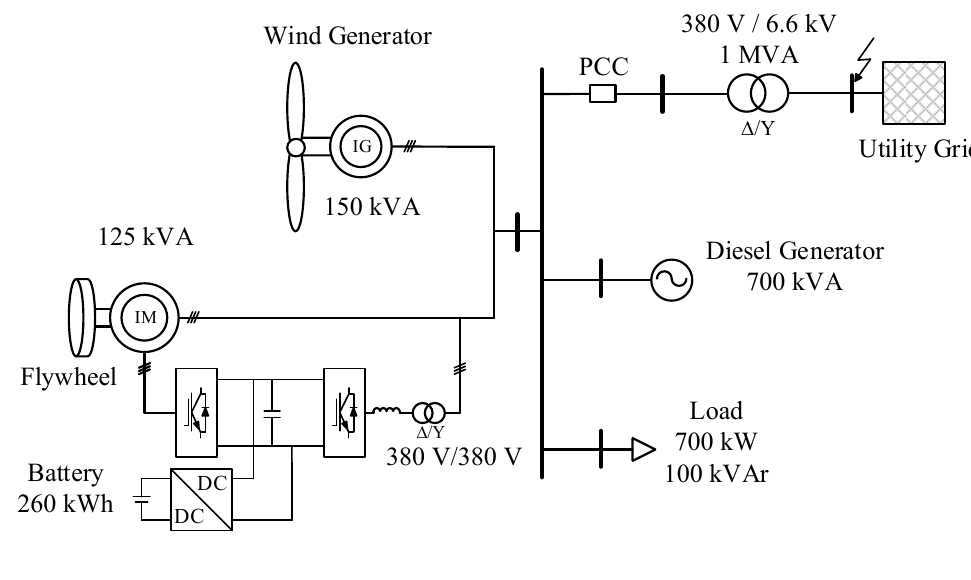
Figure 5. Configuration of the microgrid.